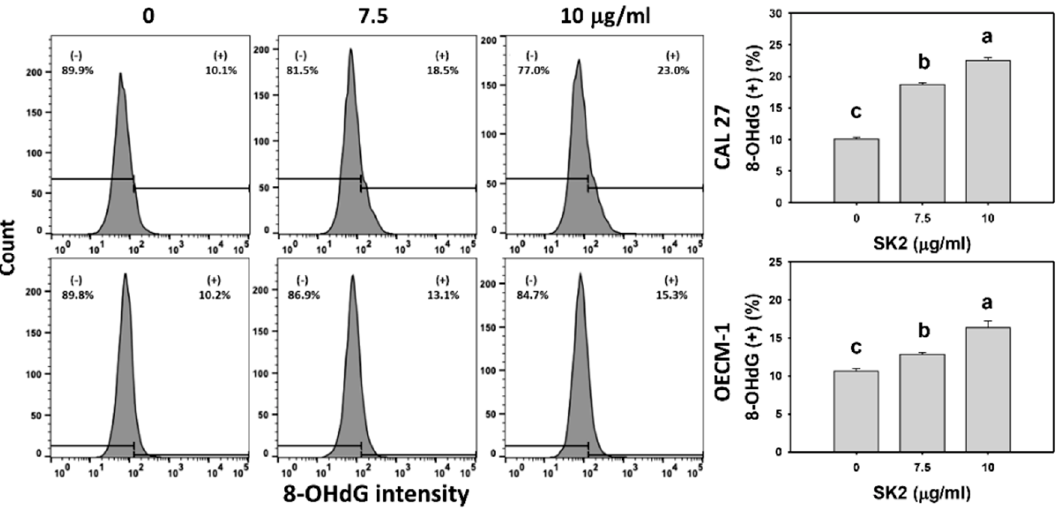
Figure 9. SK2 prompts 8-OHdG induction in oral cancer cells. 8-OHdG detections and statistics are provided. Cells were exposed to SK2 (0 (0.1% DMSO), 7.5, and 10 µg/mL) for 24 h. (+) in each panel represents 8-OHdG (+). Data (means ± SDs; n = 3) without overlapping characters differed significantly ( p < 0.05). For an example of CAL 27 and OECM-1 cells, for different concentrations, different characters indicate significant differences.